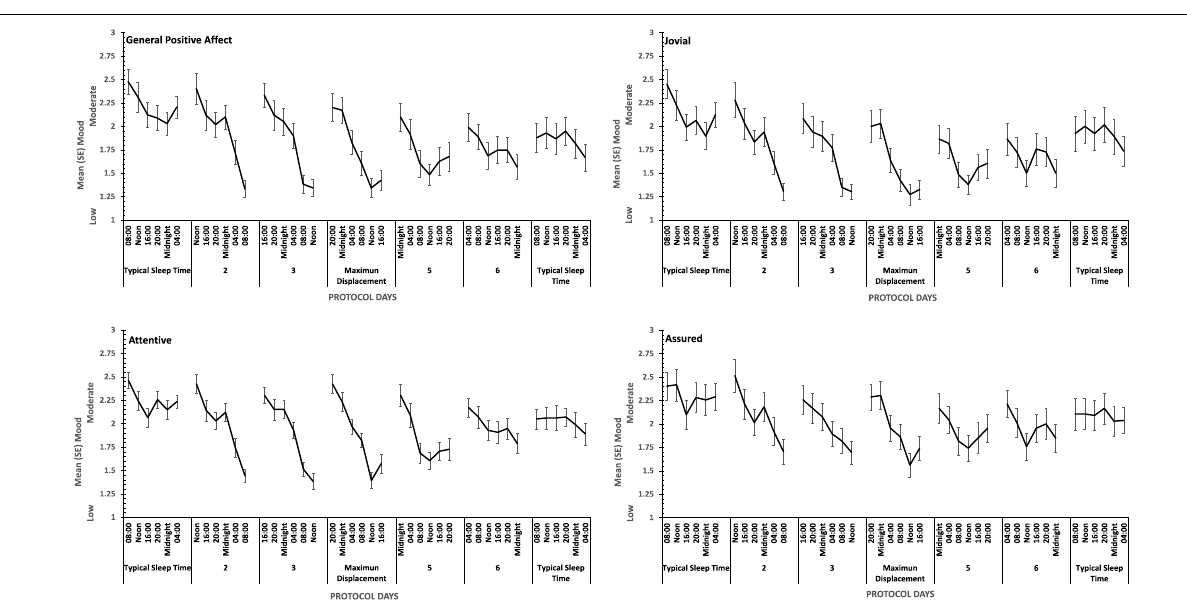
Confusion and Fatigue when there are any at all, and (c)